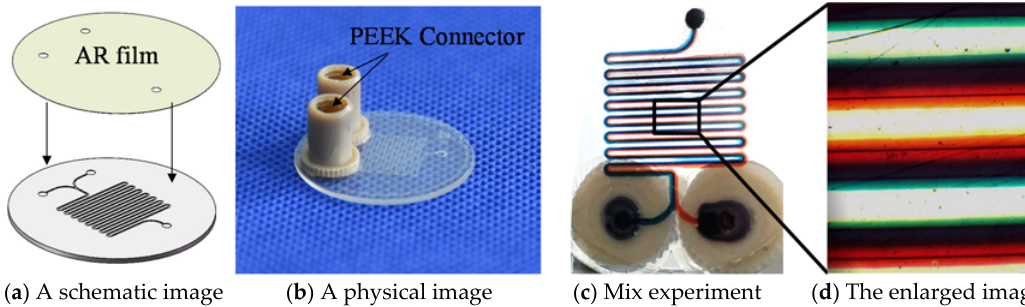
Figure 13. The experiment of filling the mixing microfluidic system. ( a ) A schematic image; ( b ) A physical image; ( c ) Mix experiment; ( d ) The enlarged image.